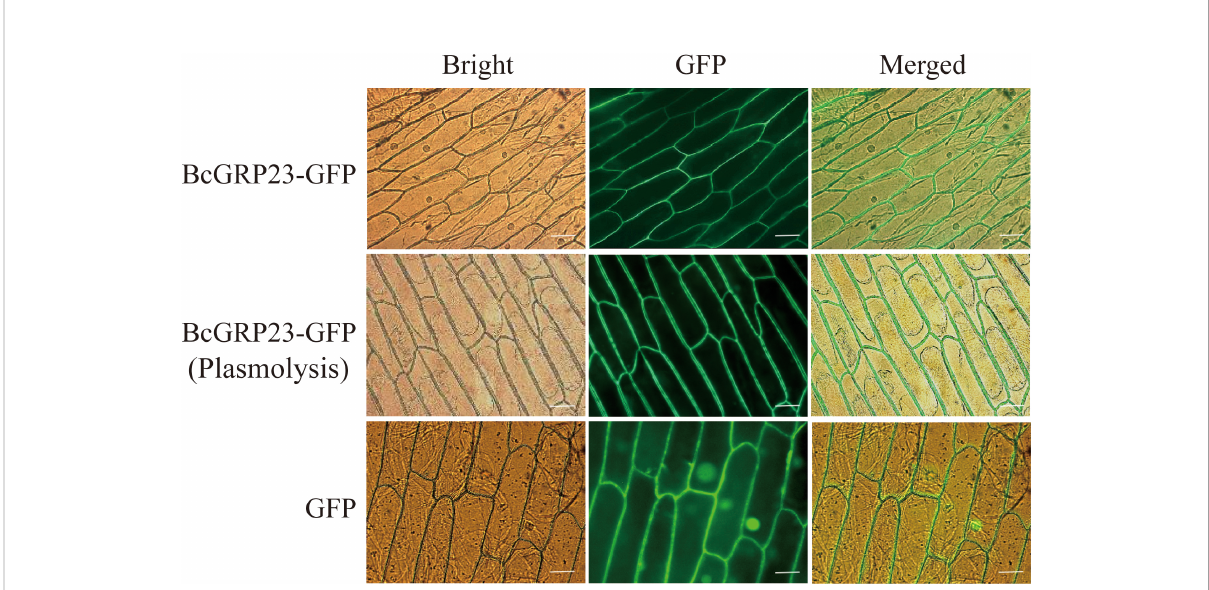
FIGURE 2 Subcellular localization of BcGRP23 . The vectors 35S::GFP (pBI121-GFP, positive control) and 35S:BcGRP23-GFP (pBI121-BcGRP23-GFP) were injected into onion epidermal cells and visualized with a fl uorescence microscope after 24 h of bombardment. Bar , 25 m m.